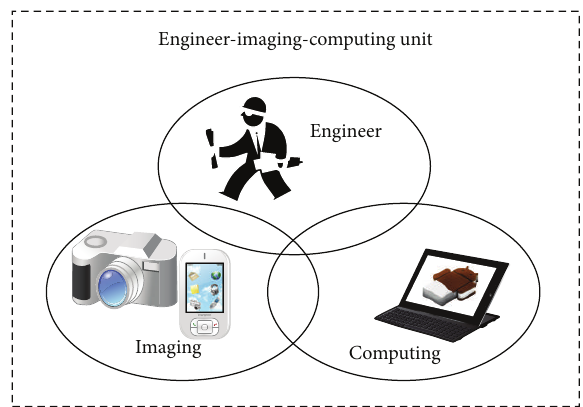
Figure3:Thestructureofanengineer,imaging,andcomputingunit in the field.